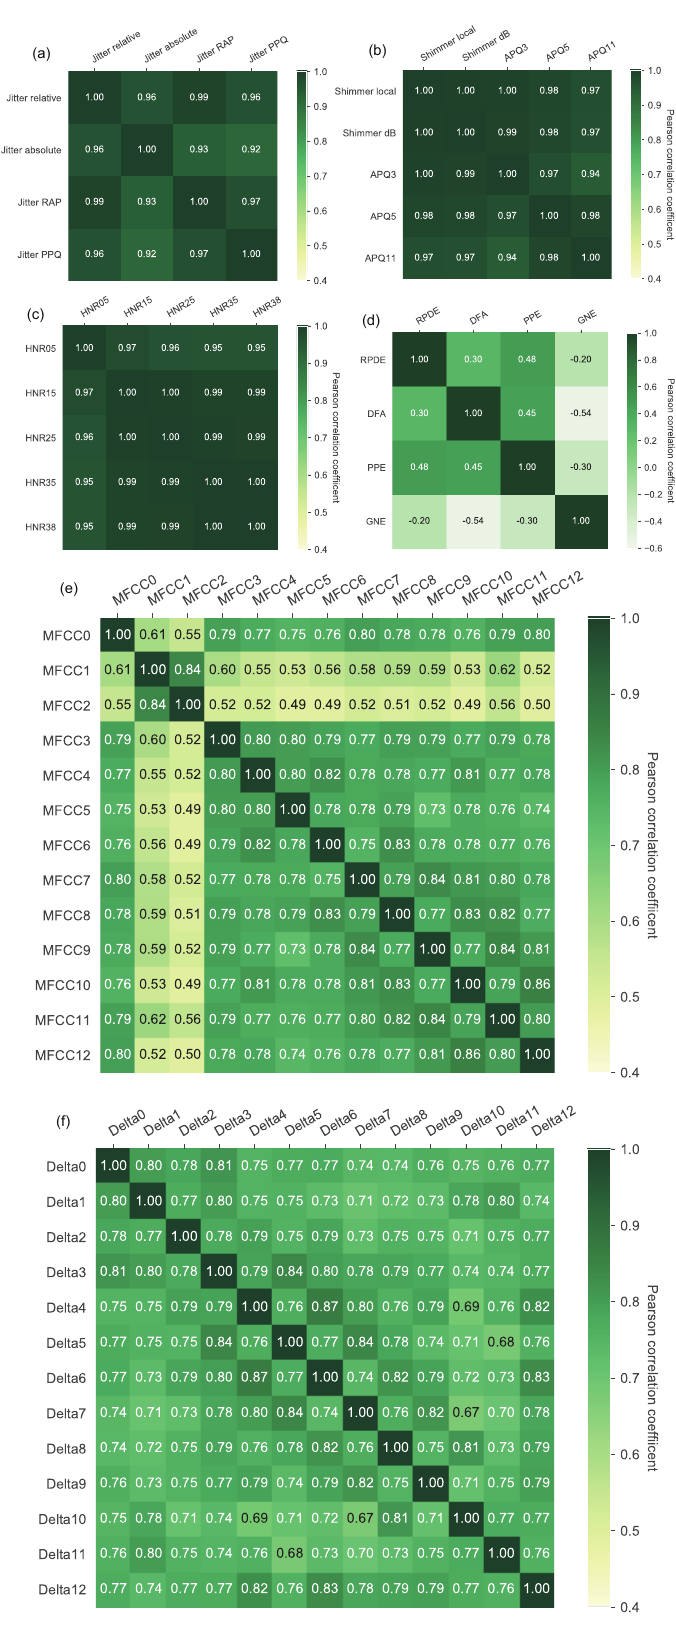
Figure 2. Pearson correlation coefficient results of the families of ( a ) Jitter, ( b ) Shimmer, ( c ) HNR, ( d ) Nonlinear, ( e ) MFCC, and ( f ) Frequency Delta vocal